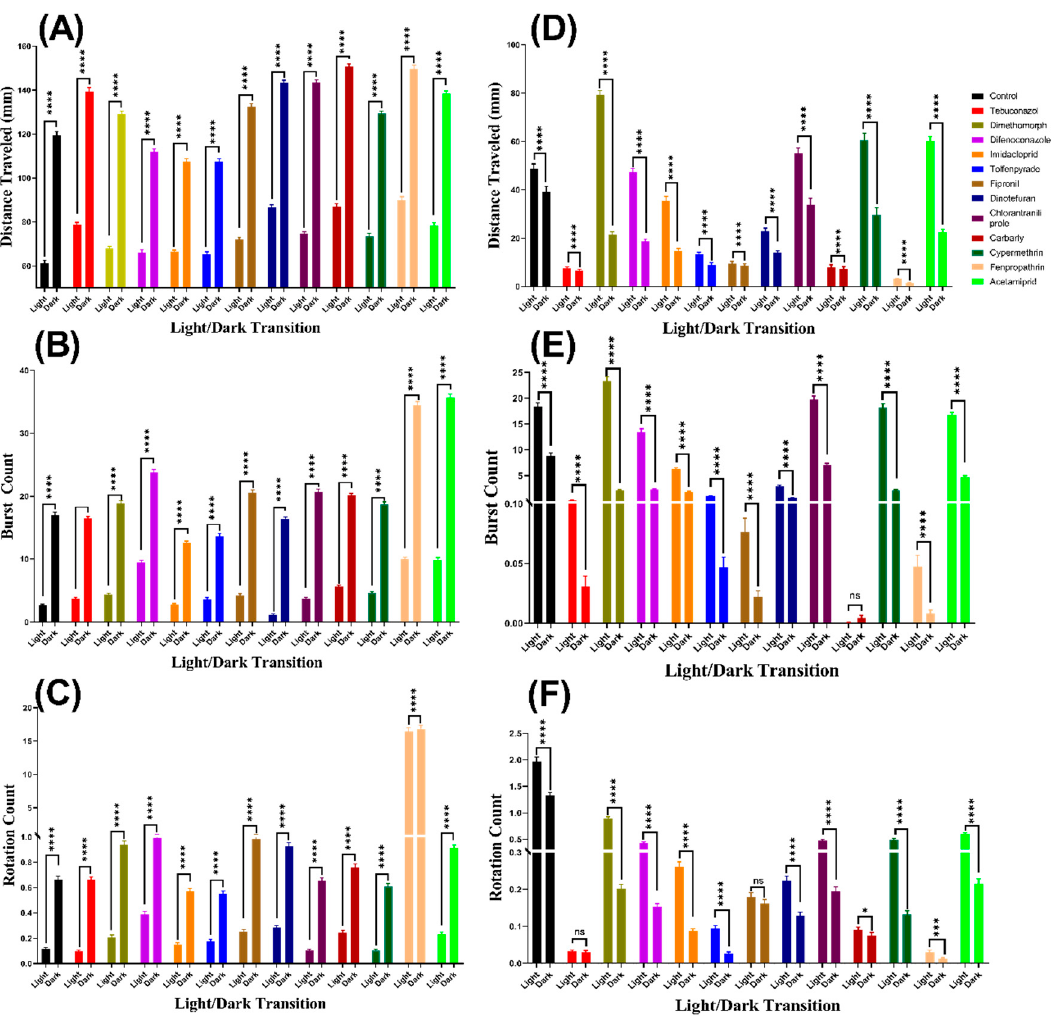
Figure A1. Comparison of ( A , D ) distance traveled, ( B , E ) burst count, and ( C , F ) rotation count between the light and dark cycles in each group of ( A – C ) zebrafish and ( D – F ) Daphnia magna , respectively. The data are expressed as the Mean ± SEM and analyzed by Mann–Whitney test ( n zebrafish = 24, n Daphnia magna = 48; ns = not significant, * p < 0.05, *** p < 0.001, **** p < 0.0001